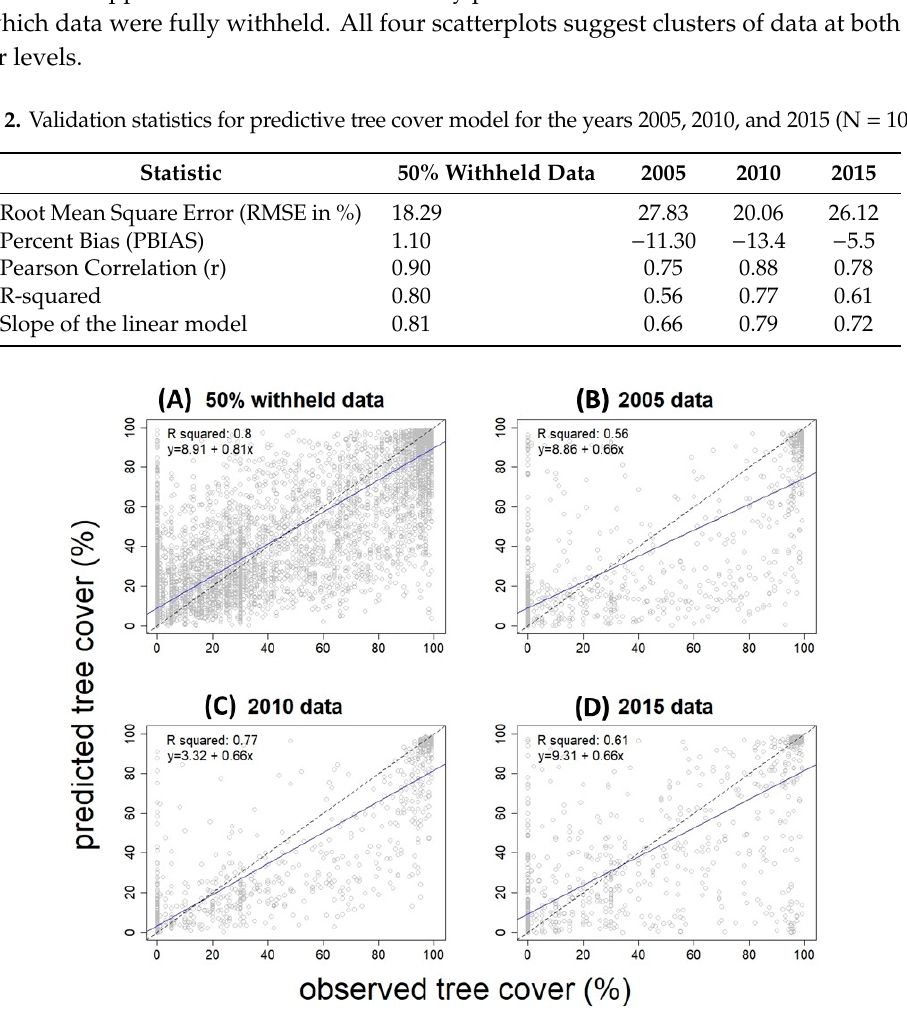
Figure 3. Observed versus predicted tree-cover validation for the 50% randomly withheld validation data ( A ), randomly selected independent validation data from 2005 ( B ), randomly selected independent validation data from 2010 ( C ), and randomly selected independent validation data from 2010 ( D ).